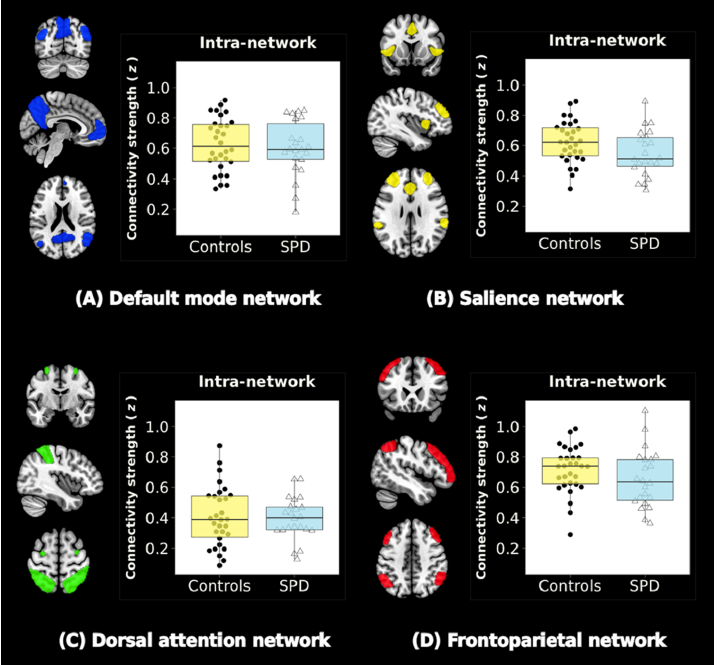
Figure 2. Resting-state networks (RSNs) and intra-network connectivity. Four RSNs are shown: ( A ) the default mode network (DMN), ( B ) the salience network (SN), ( C ) the dorsal attention network (DAN), and ( D ) the frontoparietal network (FPN). Color-bar graphs summarize the results of comparisons between SPD and control groups. Z-values indicate the functional connectivity strength within the network. There were no significant group differences in intra-network functional connectivity (FDR-corrected p -values >